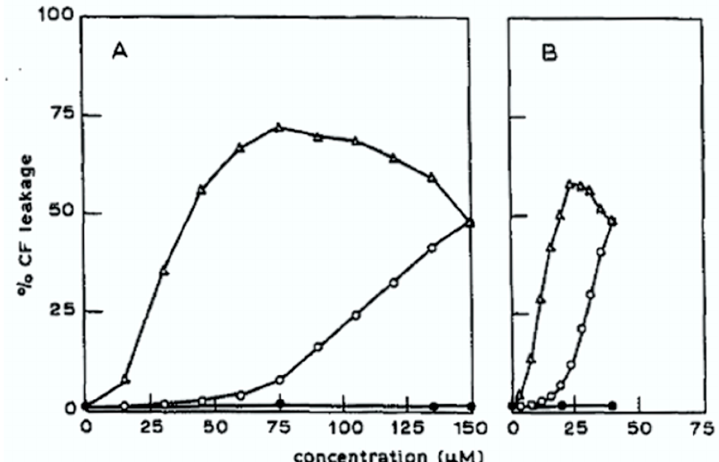
Figure 5. Glycoalkaloid induced leakage of the dye carboxyfluorescein from liposomes of egg yolk phosphatidylcholine containing ( A ) cholesterol or ( B ) fucosterol. The leakage was measured 5 min after addition of the indicated amounts of α -chaconine (open circles), α -solanine (solid circles), or an